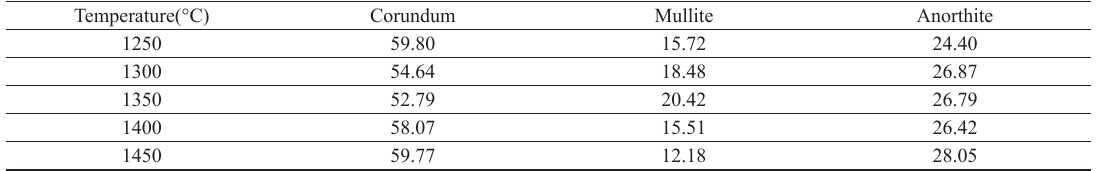
Table 2. The crystal phase contents of the samples (wt%).